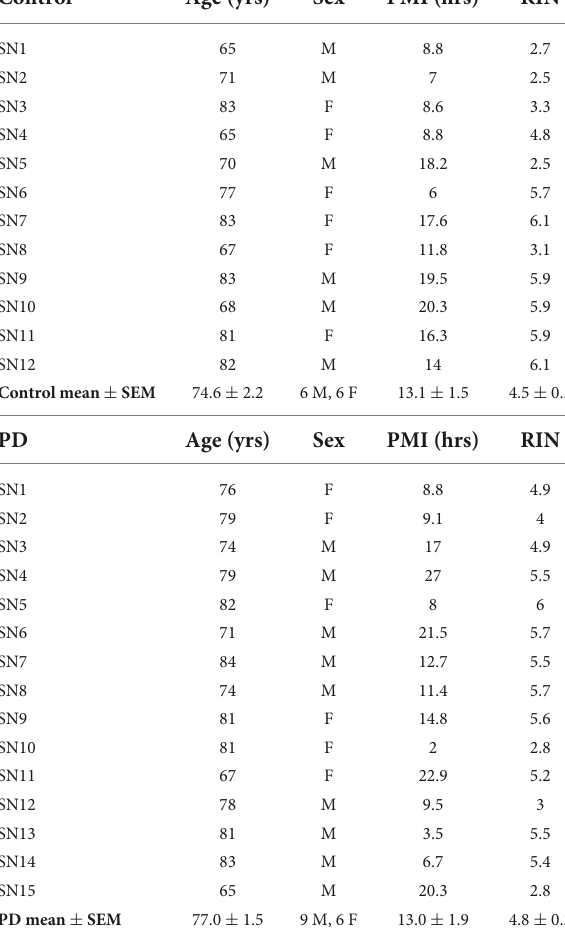
TABLE 1 Subject and tissue characteristics: Substantia nigra.